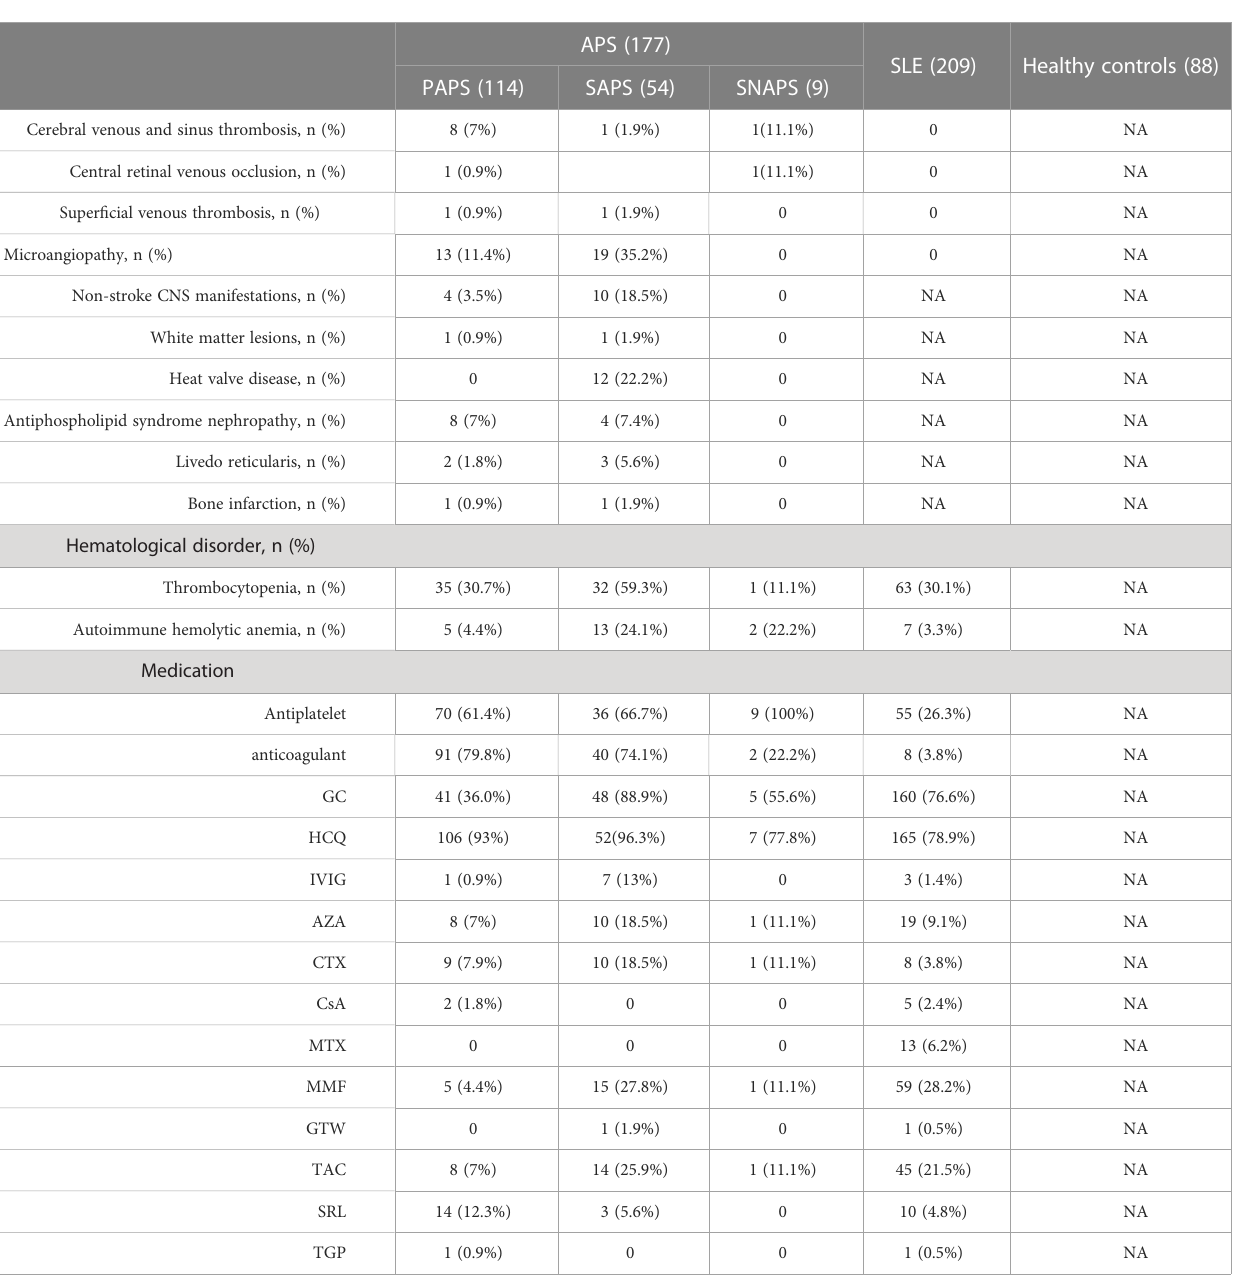
occurred were stroke (21.1% in PAPS, 16.7% in SAPS, and 11.1% in SNAPS) and deep vein thrombosis (38.6% in PAPS and 33.3% in SAPS). Regarding medication, 70 (61.4%) PAPS, 36 (66.7%) SPAS, 9 (100%) SNAPS, and 55 (26.3%) SLE patients had taken antiplatelet medicines. There were 91 (79.8%) PAPS, 40 (74.1%) SAPS, 2 (22.2%) SNAPS, and 8 (3.8%) SLE patients taking anticoagulants, and 106 (93%) PAPS, 52 (96.3%) SAPS, 7 (77.8%) SNAPS, and 165 (78.9%) SLE patients on hydroxychloroquine. In addition, 41 (36.0%) PAPS, 48 (88.9%) SPAS, 5 (55.6%) SNAPS, and 160 (76.6%) SLE patients received glucocorticoid therapy upon